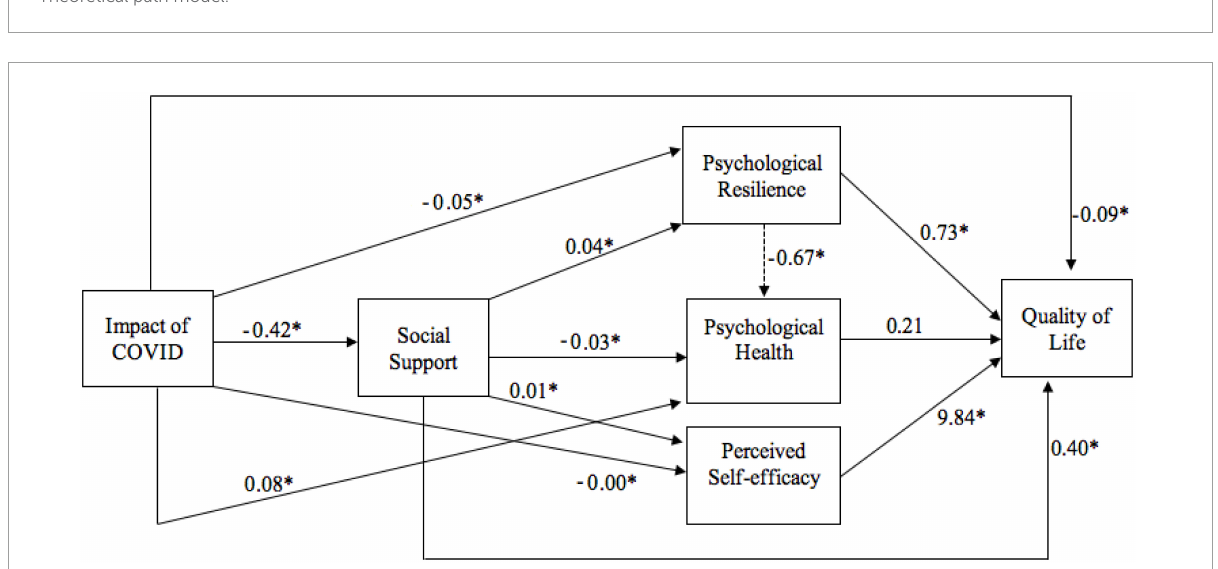
FIGURE2 Final path model. Dashed line represents modification; * p < 0.05; all effects are unstandardized effects.